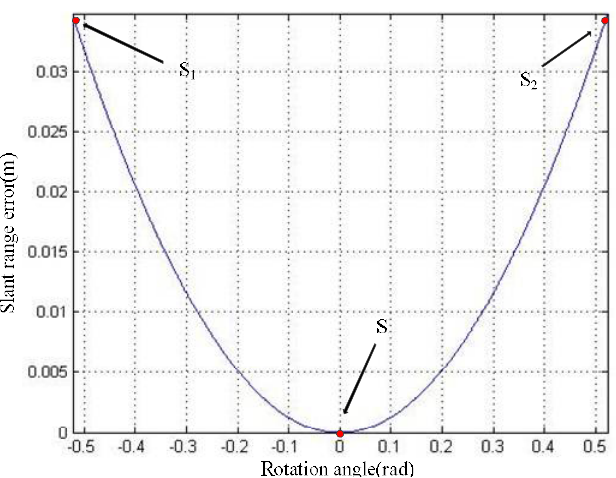
Figure 3. The θ – ∆ R relationship curve. Figure 3. The θ –∆ R relationship curve.